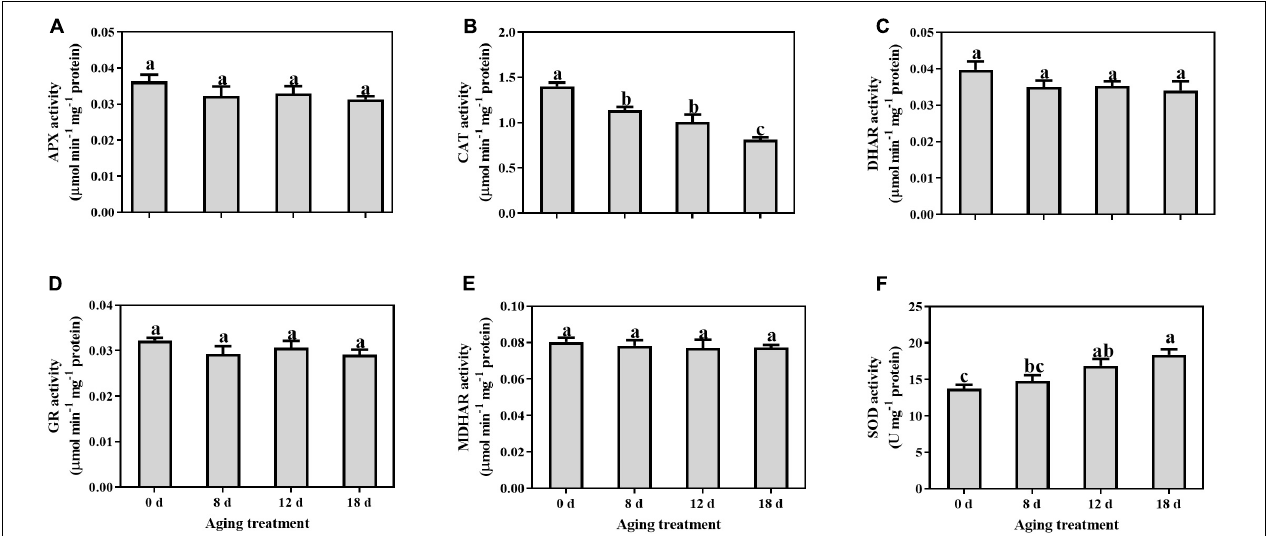
FIGURE 1 | Changes in the activities of (A) APX, (B) CAT, (C) DHAR, (D) GR, (E) MDHAR, and (F) SOD in the embryonic axis during seed aging. Data shows the mean ± SD of three biologically independent experiments. Columns marked with different letters (a-c) are statistically significantly different ( p < 0.05).